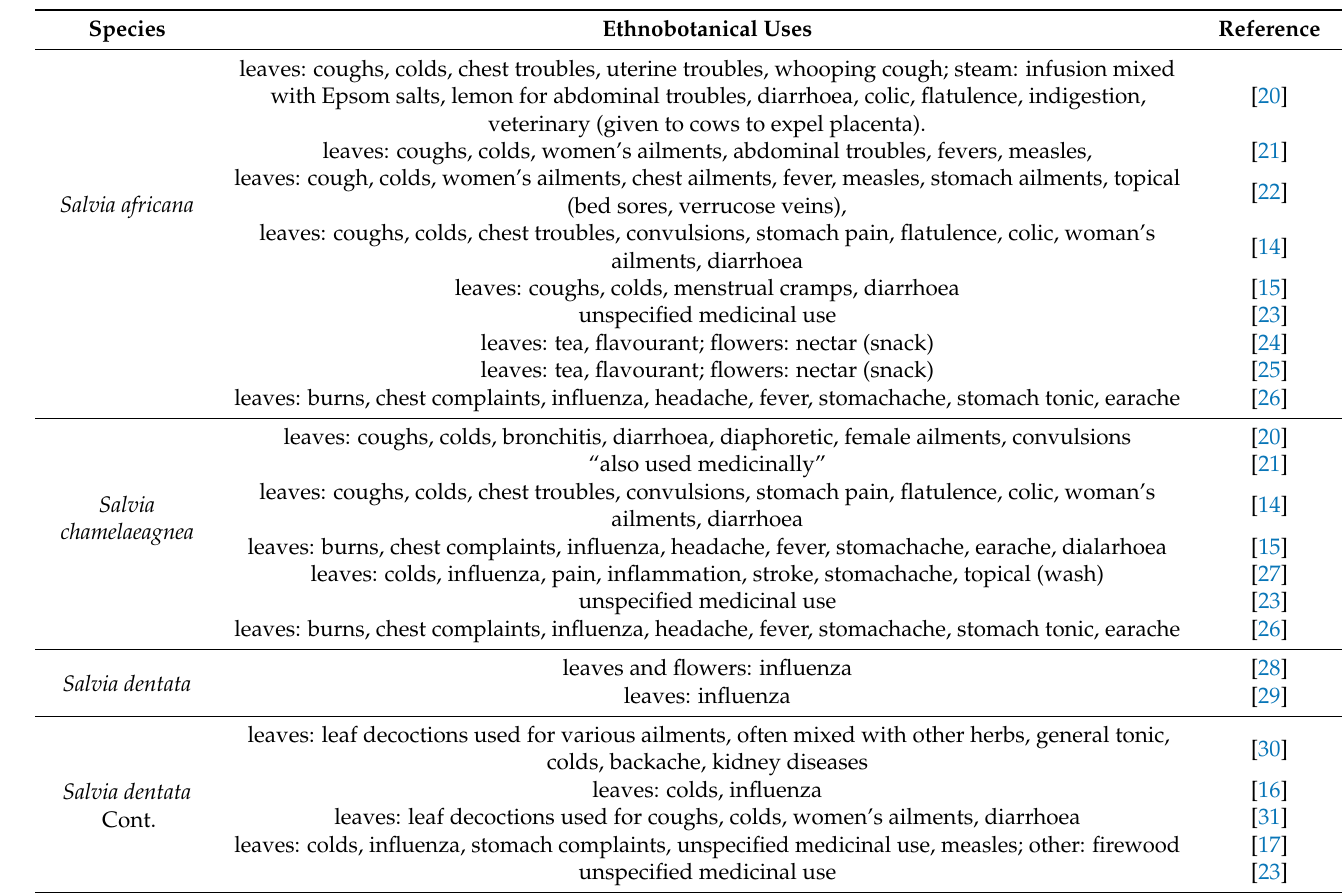
Figure 6. Number of medicinal use-records per use category for the three Cape blue-flowered Salvia species. Table 1. Recorded ethnobotanical uses for the three medicinal, blue-flowered